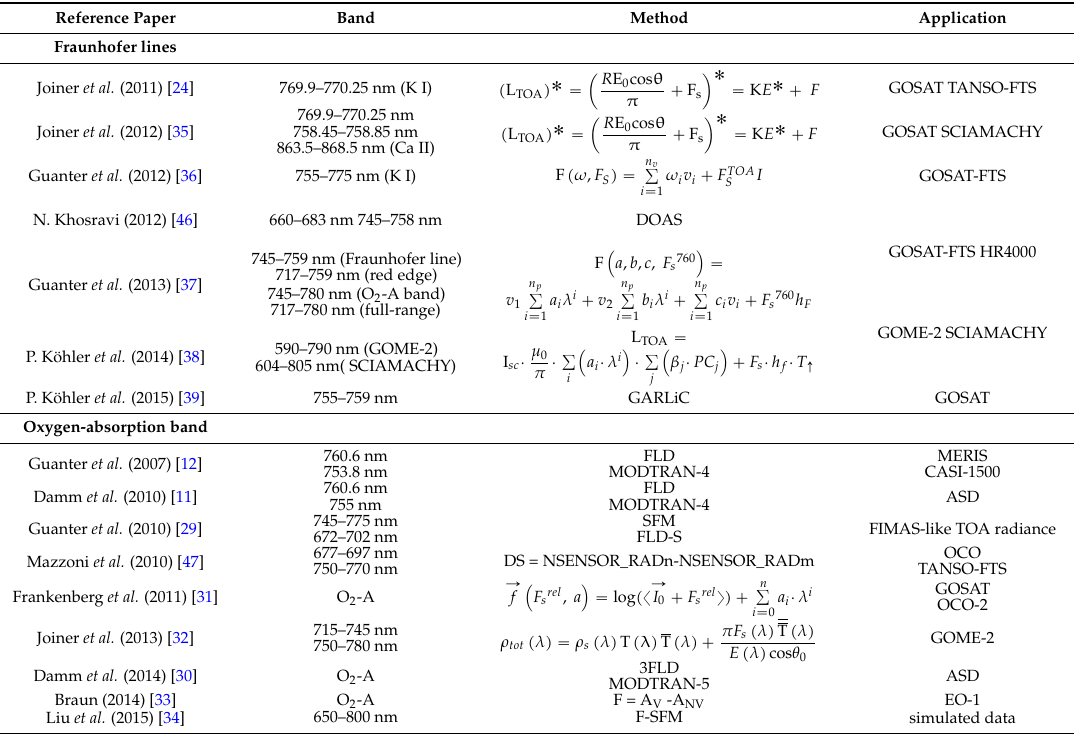
Table 4. Review of the methods for retrieving fluorescence from space-borne